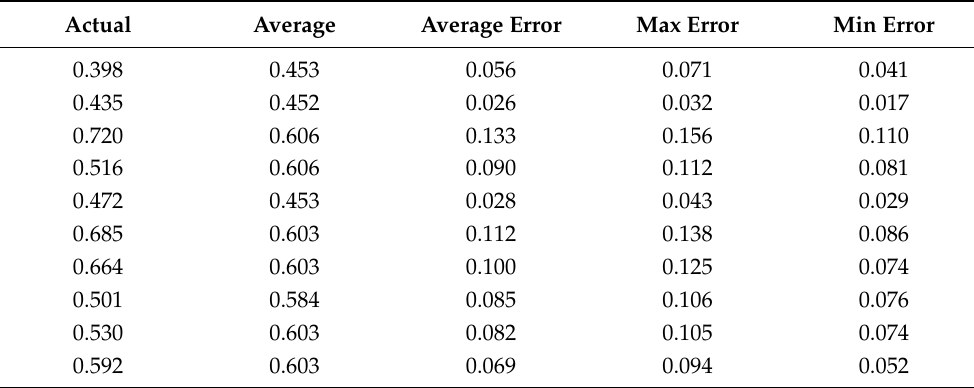
Table A157. Set 3, trials 1–10 data (single 0.5 PR